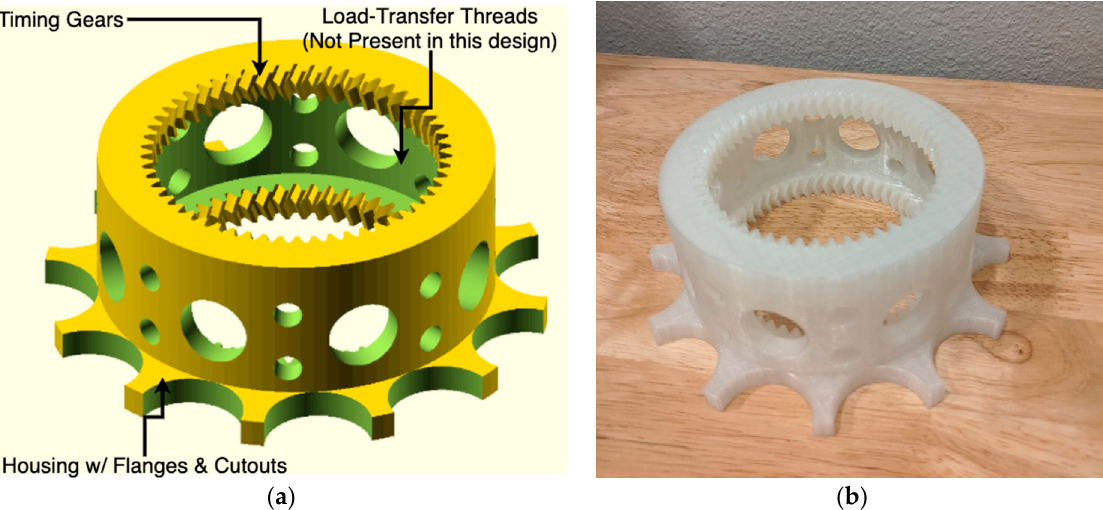
Figure A3. ( a ) Finished and labeled rendering of the outer nut assembly. ( b ) Three-dimensional (3D)-printed outer nut assembly. Printed on an open source PrusaMK3S with natural PLA at 0.2 mm layer height. Printed in shown orientation with support material on inner diameter to support ring gears.